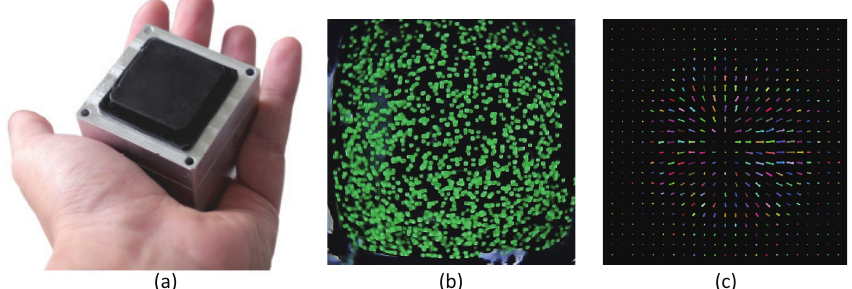
Figure 4. Example of tactile image sensor using a camera based on the marker displacement method. ( a ) Picture of a full-resolution optical tactile sensor developed by ETH Zurich research group [26]; ( b , c ) are the original image and dense optical flow computed with the DIS algorithm. Note that the flow is estimated at each pixel, and a subsampled version is shown in ( c ) for ease of visualization [26]. (Source: C. Sferrazza and R. D’Andrea, “Design, Motivation and Evaluation of a Full-Resolution Optical Tactile Sensor,” Sensors , 19, 2019